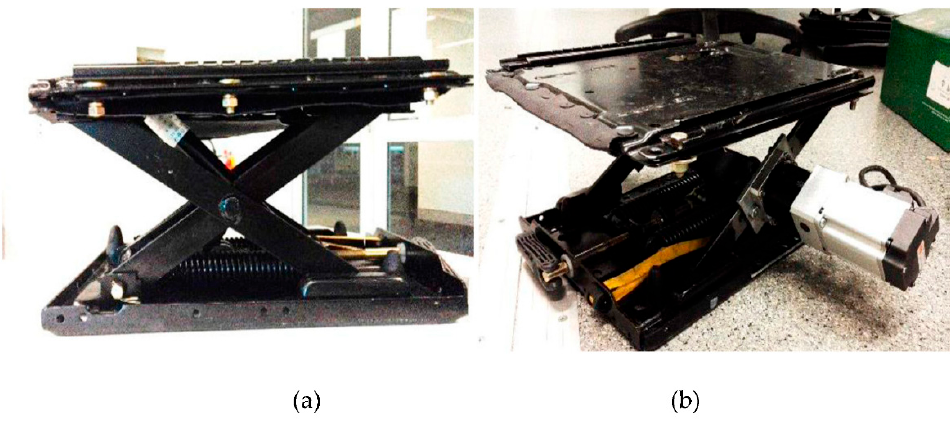
Figure 3. Seat suspension system. ( a ) Passive seat suspension. ( b ) Active seat suspension [45].